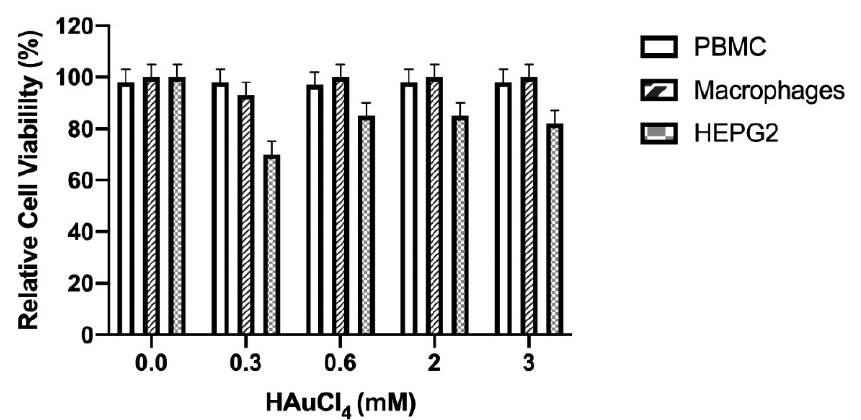
Figure 8. Relative cell viability of PBMC, macrophages, and HEP-G2 cells in the presence of concen- trations of CTS-AuNPs in a liquid medium (0.3, 0.6, 2, and 3 mM); n = 3, SD ± 0.5, p < 0.05.